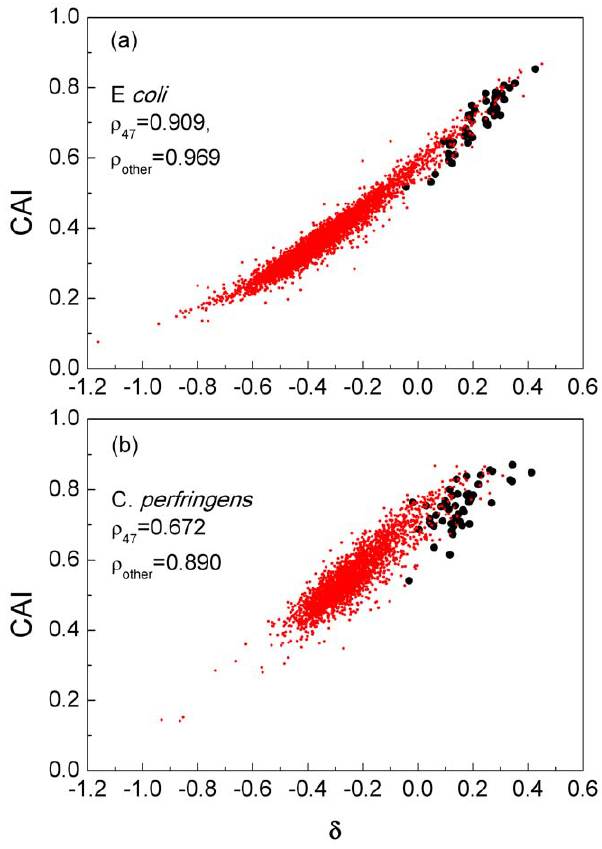
Figure 4. Variation in codon bias among genes in E.coli and C. perfringens , as measured by CAI and d . Large black points - 47 high-expression reference genes. Small red points - all other genes. r is the spearman rank correlation